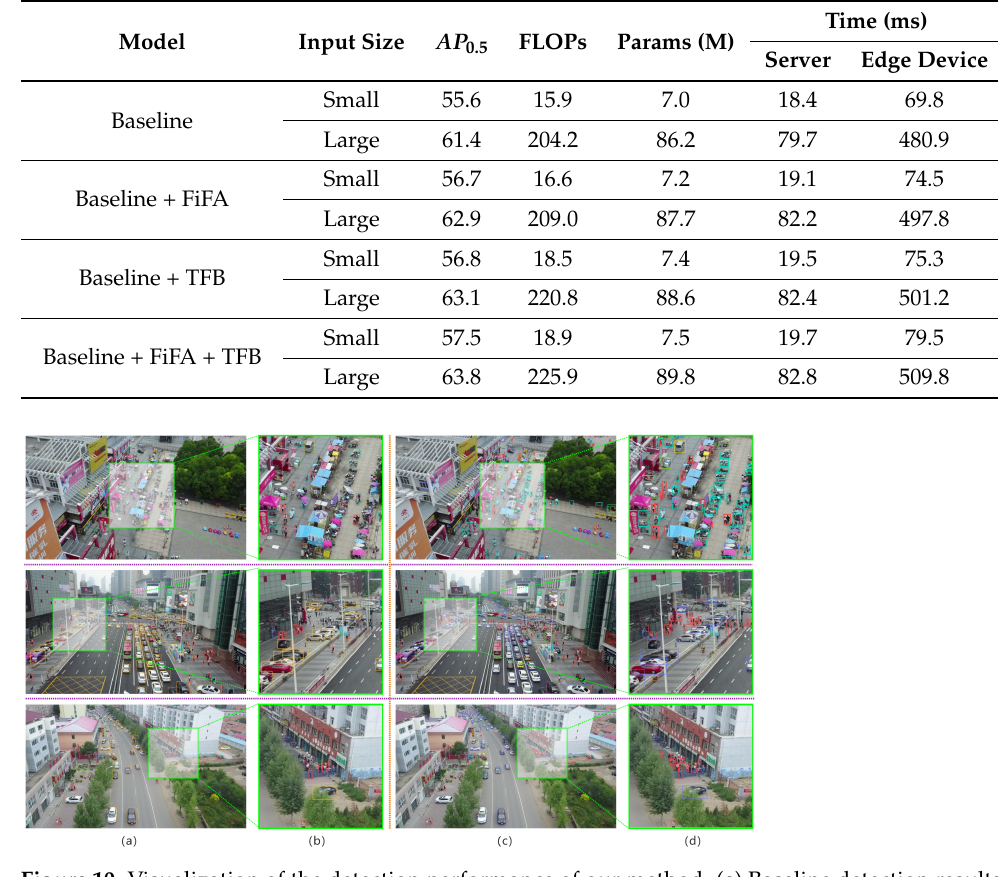
Table 5. Comparison of model complexity between our model and the baseline.